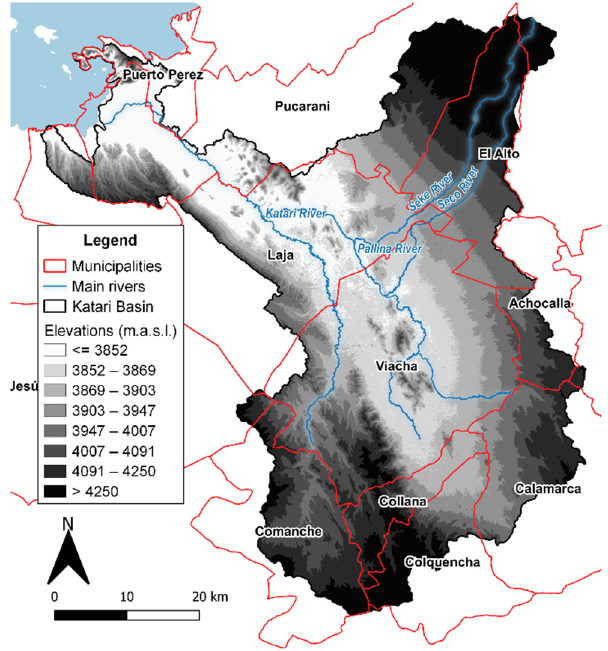
Figure 1. Municipalities that encompass the KRB and main